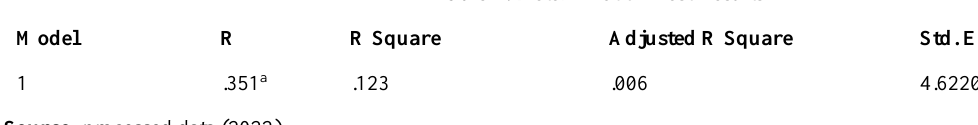
Table 4: Determination Test Results